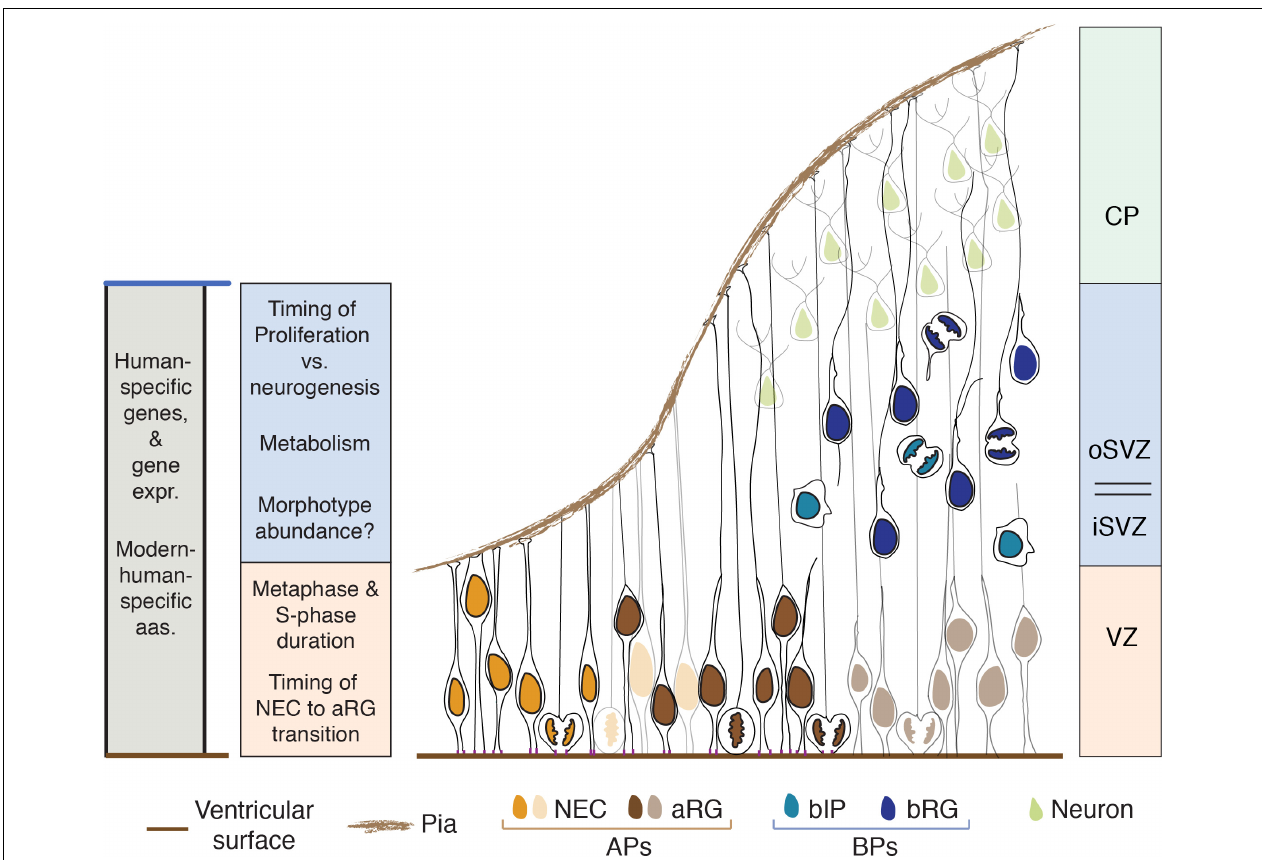
FIGURE 1 | Human-specific aspects of NSPCs that influence neocortex development. Aspects listed on the left are color-coded according to the germinal zone(s) where they play a role (right side) or shown in gray if they apply to all germinal zones (expr., expression; aas., amino acid residues). The main cell types per zone are shown; VZ, ventricular zone; subventricular zone (SVZ), subdivided in inner (iSVZ) and outer (oSVZ) SVZ; CP, cortical plate; NEC, neuroepithelial cells; aRG, apical radial glia; APs, apical progenitors; bIP, basal intermediate progenitor; bRG, basal radial glia; BPs, basal progenitors. To illustrate the progression from NECs to aRG to BPs to neurons (from left to right), the nuclei of NECs and aRG are first shown in full color and then in a pale version of the respective